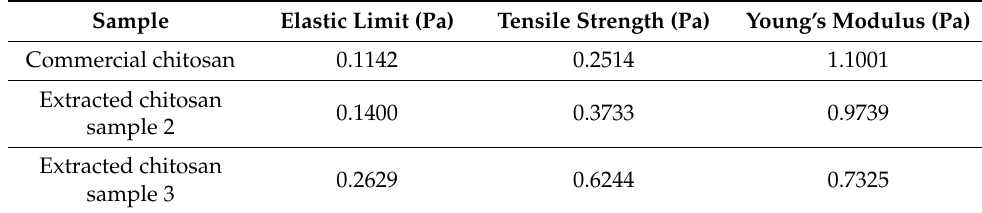
Figure 4. Stress–strain curve for chitosan biofilms. Table 3. Biofilms’ mechanical properties.